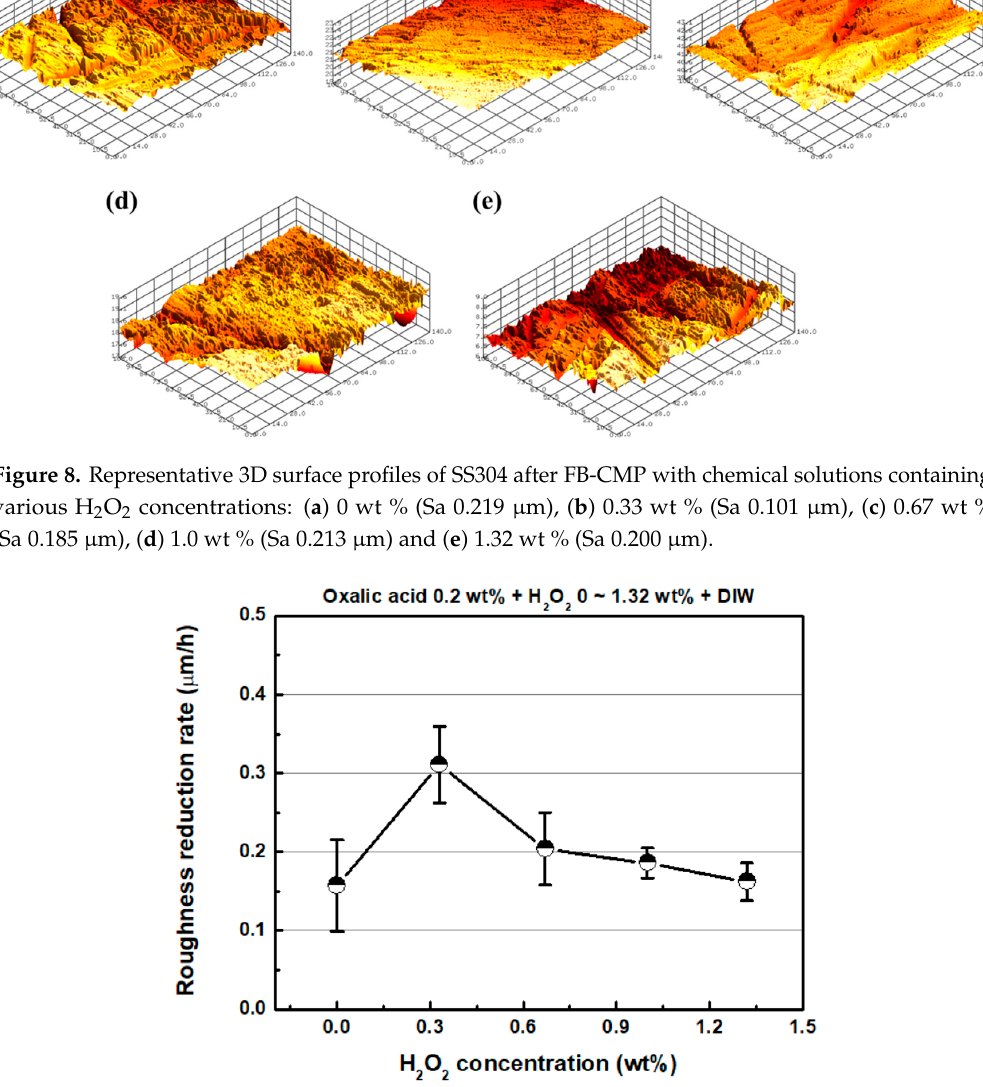
Figure 9. Roughness reduction rate as a function of H 2 O 2 concentration (oxalic acid concentration: 0.2 wt %).